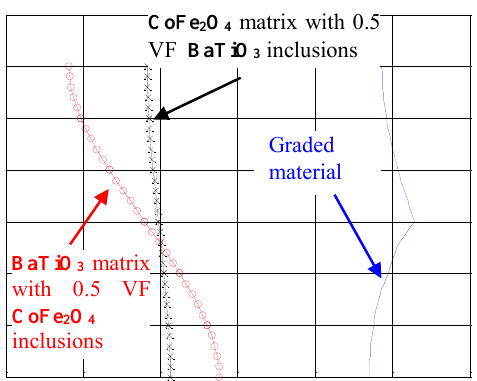
Figure 8 : Variation of the magnetic potential along the thickness direction in the graded material caused by a surface load on the top surface